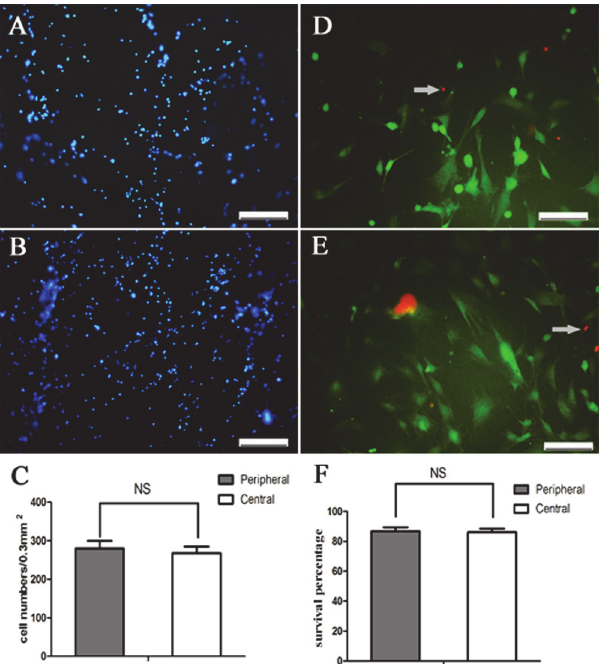
Fig 11. Distribution of iNSCs with the 3D PLGA-PEG scaffolds. On the seventh day, iNSCs that are stained with Hochest33342 were distributed evenly in peripheral (A) and central part (B). Furthermore, survival percentage of iNSCs on the seventh day in peripheral (D) and central part (E) showed no significant difference. NS indicate no significant difference between peripheral and central part (C, n = 5). Scale bars = 200 μ m (E,